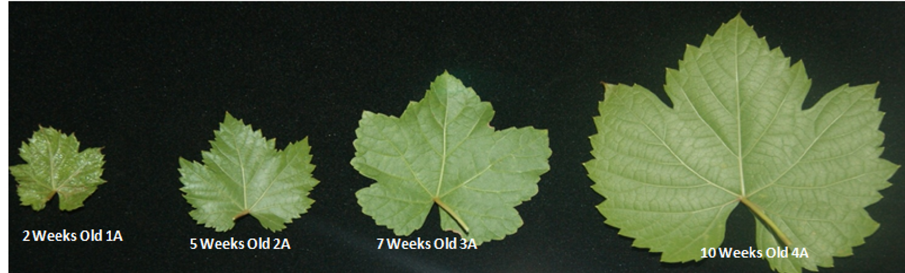
Fig 2. Overall strategy of leaf Illumina Transcriptome Sequencing, data analysis and Bioinformatics analysis pipeline.